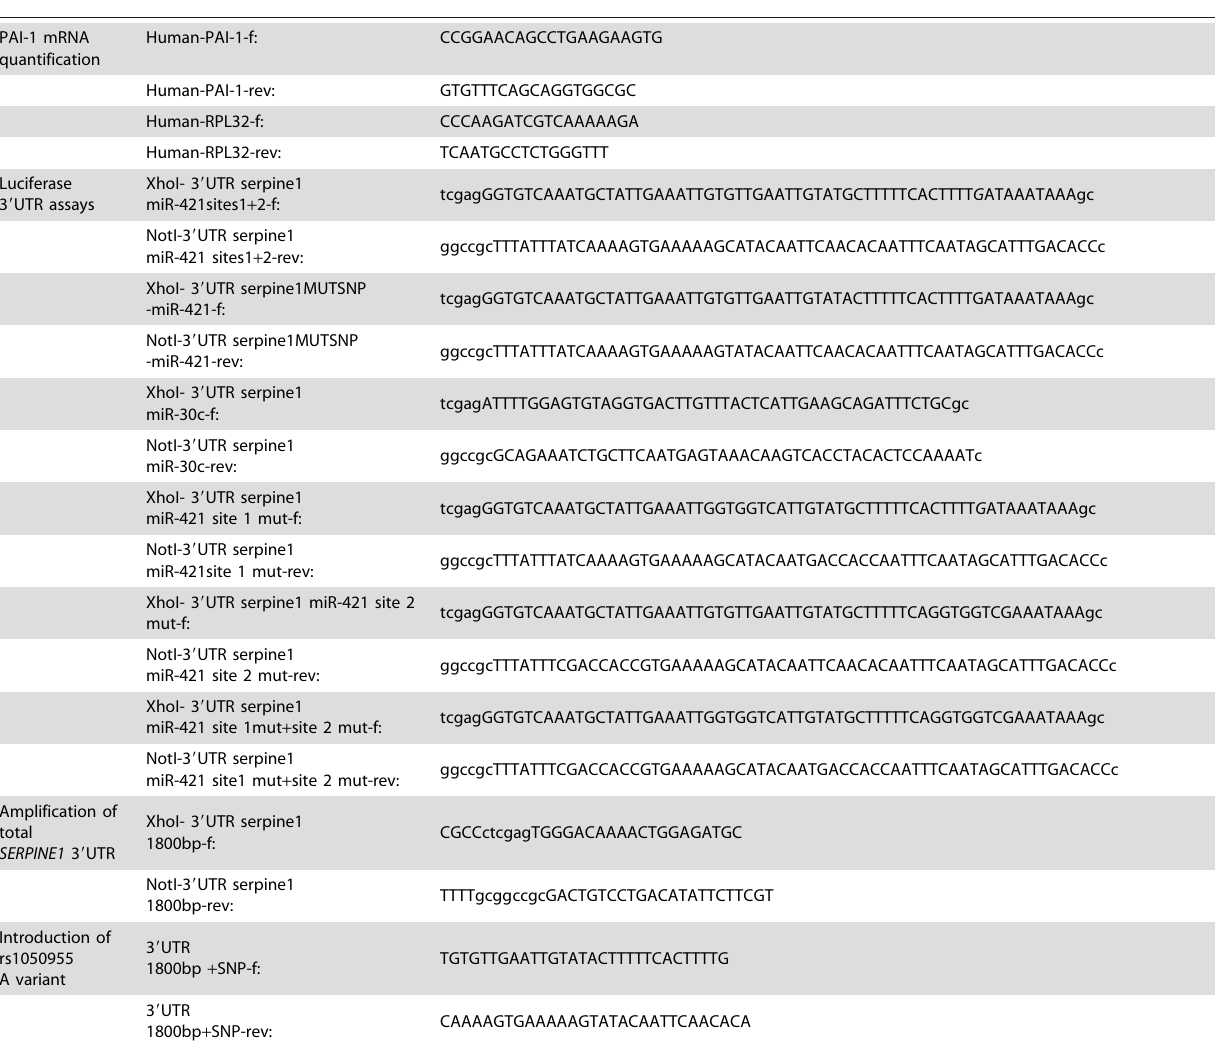
Table 3. Oligonucleotides used in this study.